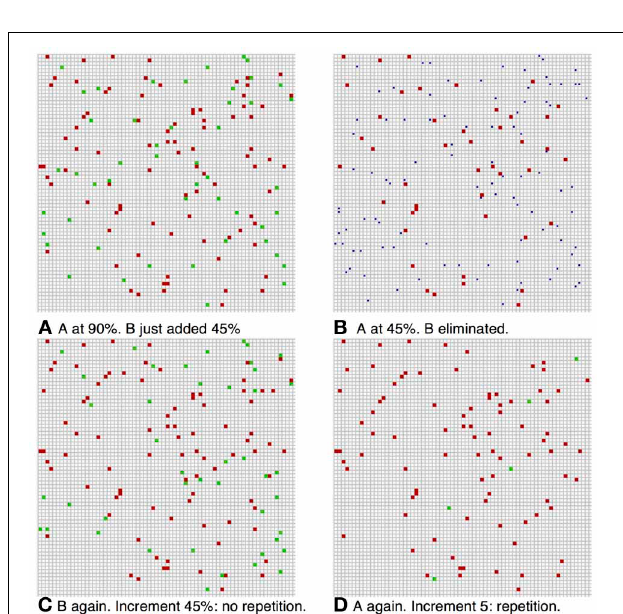
regime p fire , high = 0 . 9 . Right panel: fraction of selective units active on intermediate test images. First boxplot shows the initial activity upon presentation of the image. The second boxplot shows the activity after running the network in the high noise regime, starting with the high activity level of the sample image.